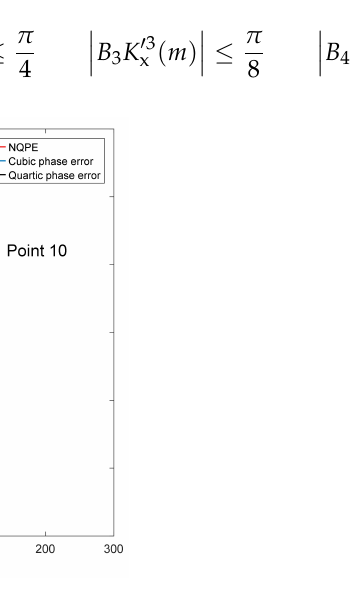
Figure 19. Swath limits for the NQPE, cubic phase error and quartic phase error and three simulated targets. The red, blue and black contour lines represent the swath limits for the NQPE, cubic phase error and quartic phase error, respectively.